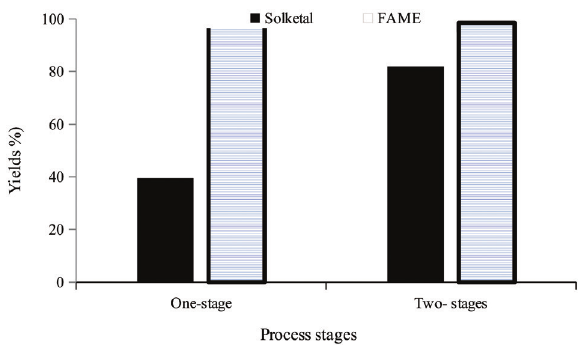
Figure 4: One- and two-stage processes for the reactive coupling of FAME and solketal co-productions at 7:1 of acetone to oil molar ratio, 0.5 of DBSA catalyst concentration, 50°C, 8 h and 10:1 of methanol to oil molar ratio.